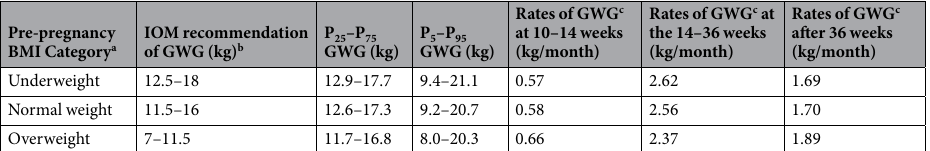
Table 2. The ranges and rates of GWG stratified by pre-pregnancy BMI categories. Note: a WHO Asian BMI standard is used for developing the ranges and rates of GWG, the pre-pregnancy BMI cut-offs for underweight, normal weight and overweight are < 18.50 kg/m 2 , 18.50–22.99 kg/m 2 , 23.00–27.49 kg/m 2 respectively. b In IOM recommendation, the pre-pregnancy BMI cut-offs for underweight, normal weight and overweight are < 18.5 kg/m 2 , 18.5–24.9 kg/m 2 , 25.0–29.9 kg/m 2 respectively. c The rates of GWG at the 10–14 weeks (kg/week) are the coefficients of T1 of regression equation in Table 3 (kg/month = kg/week * 4.34524), the coefficients of T2 for the rates of GWG at the 14–36 weeks (kg/week), and the coefficients of T3 for the rates of GWG after the 36 weeks (kg/week). Abbreviations: GWG, gestational weight gain; BMI, body mass index; IOM, Institute of